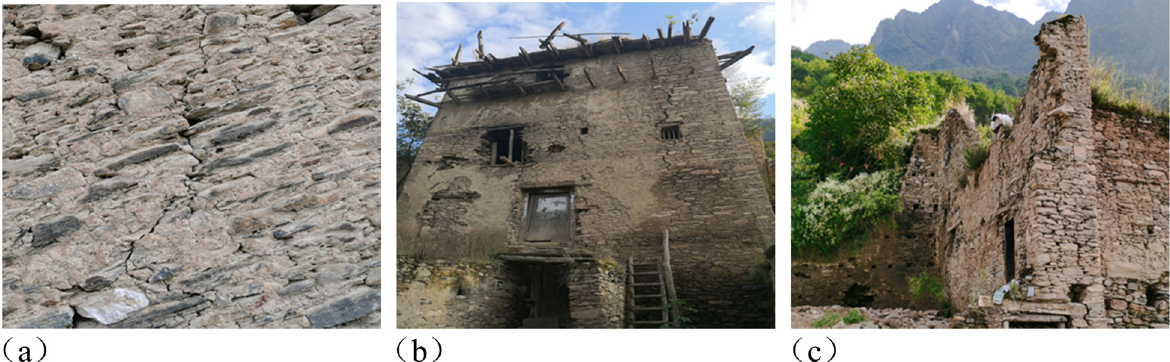
Figure 2: Disease status of Qiang village wall ( taken by author ) : ( a ) wall cracks; ( b ) wall surface soil falling o ff ; and ( c ) wall